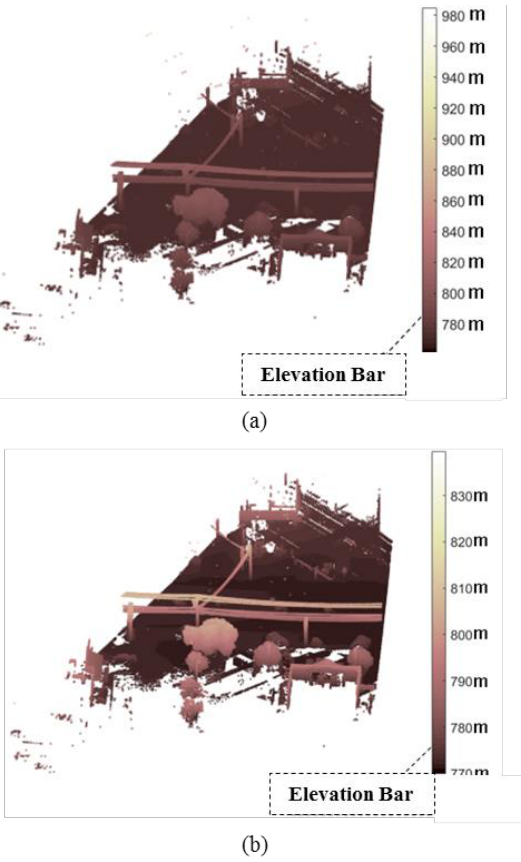
Figure 8. Noise removal of the point clouds with abnormal elevation. (a) A sample section which includes noisy points; (b) Removing the noisy points from the considered section.